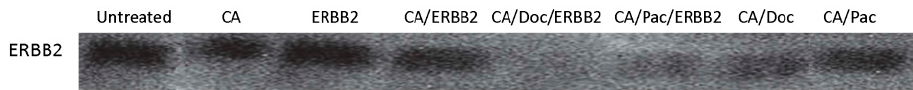
Figure 5. ERBB2 protein expression in MCF-7 cells. Cells were treated with media (untreated), carbonate apatite, free ERBB2 siRNA, CA / ERBB2 siRNA, CA / Doc / ERBB2, CA / Pac / ERBB2, CA / Doc, and CA / Pac. Ingredients include 3 mM of CaCl 2 , 1 nM siRNA, and 1 nM drug. Cellular lysates were run in SDS-PAGE and transferred into PVDF membrane and incubated with primary antibodies raised in rabbit against ERBB2. HRP-conjugated goat anti-rabbit secondary antibody was used to detect the chemiluminescent signals.